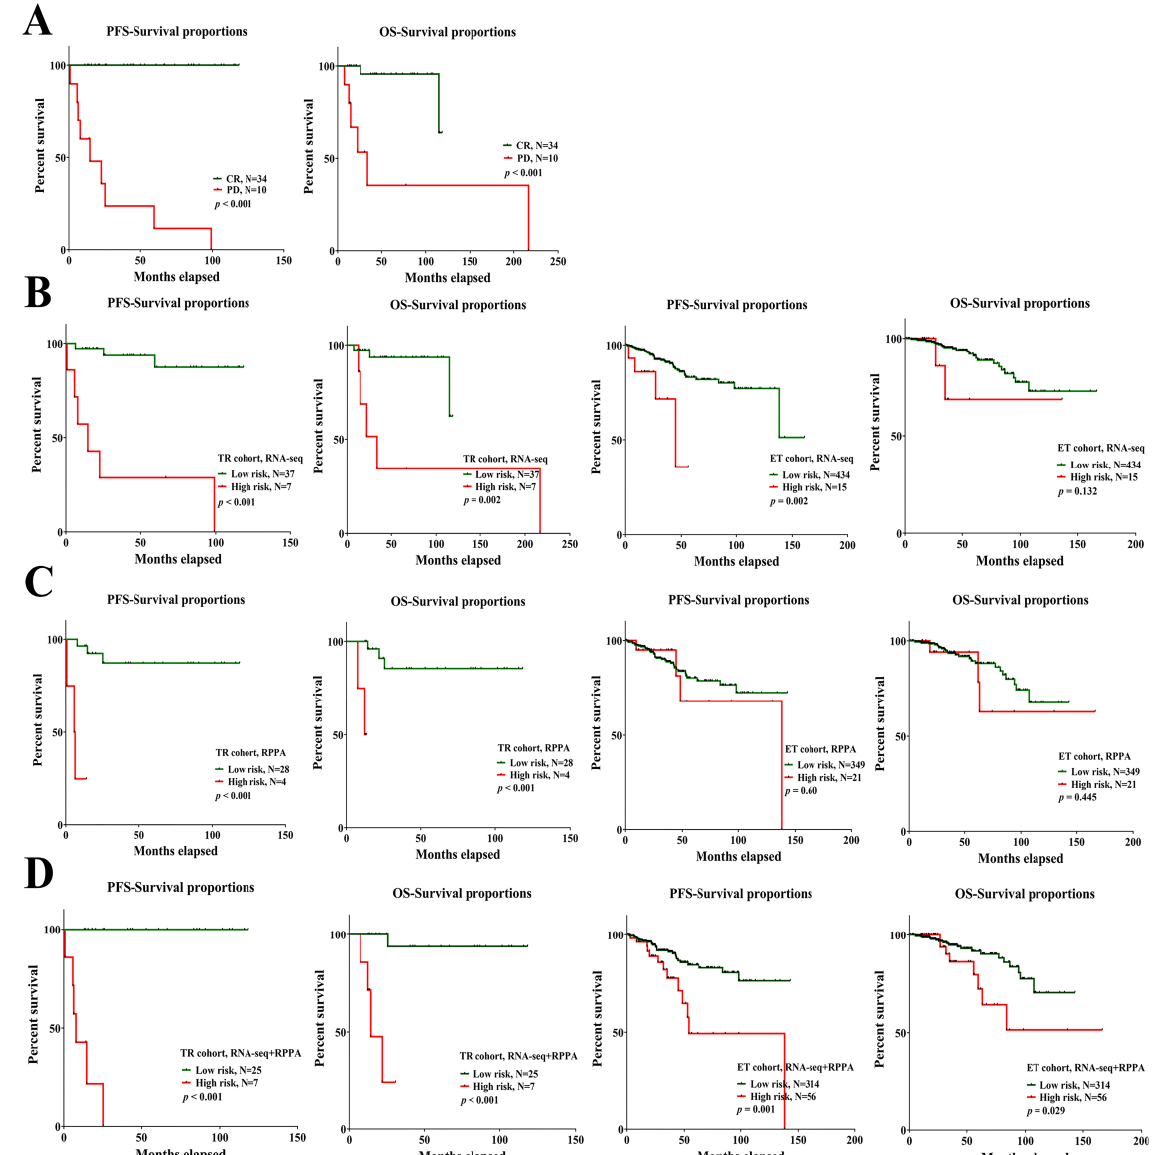
Figure 4. The survival outcomes with cumulative risk score in the treatment response and endocrine therapy cohort. ( A ) The original outcomes of PFS/OS between CR and PD groups. ( B – D ) With the mean and median value of the cumulative risk score, the survival outcomes show a significant difference between low- and high-risk groups in the treatment response and endocrine therapy